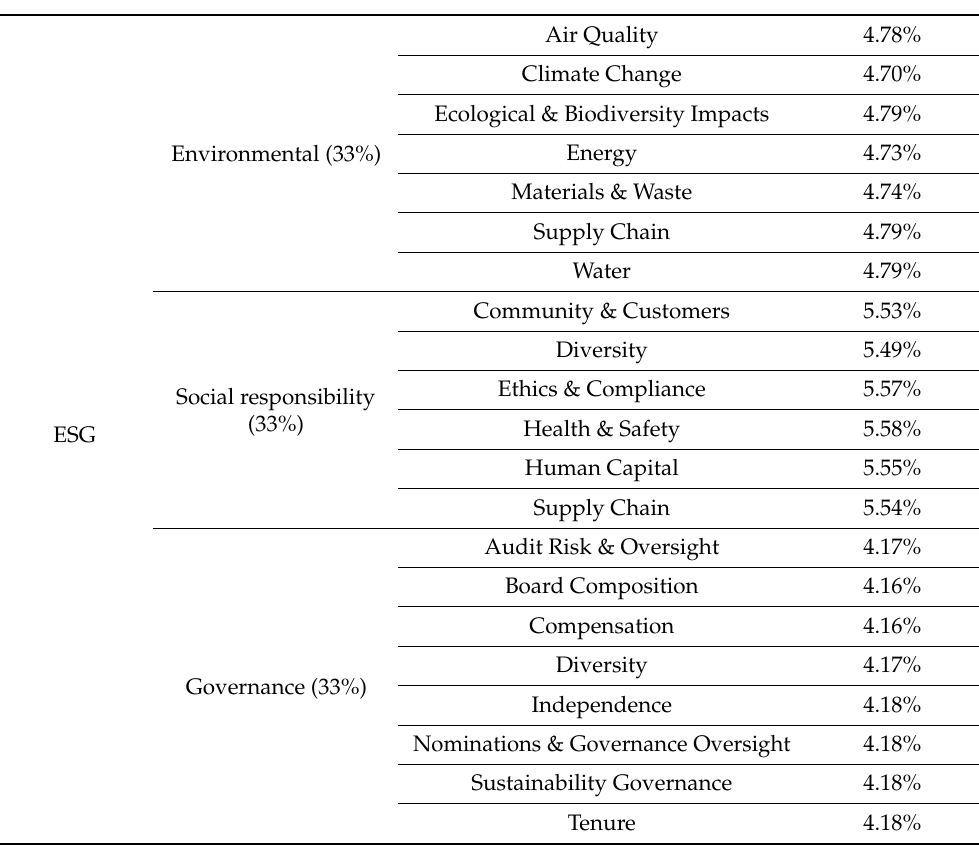
Table 1. Composition of